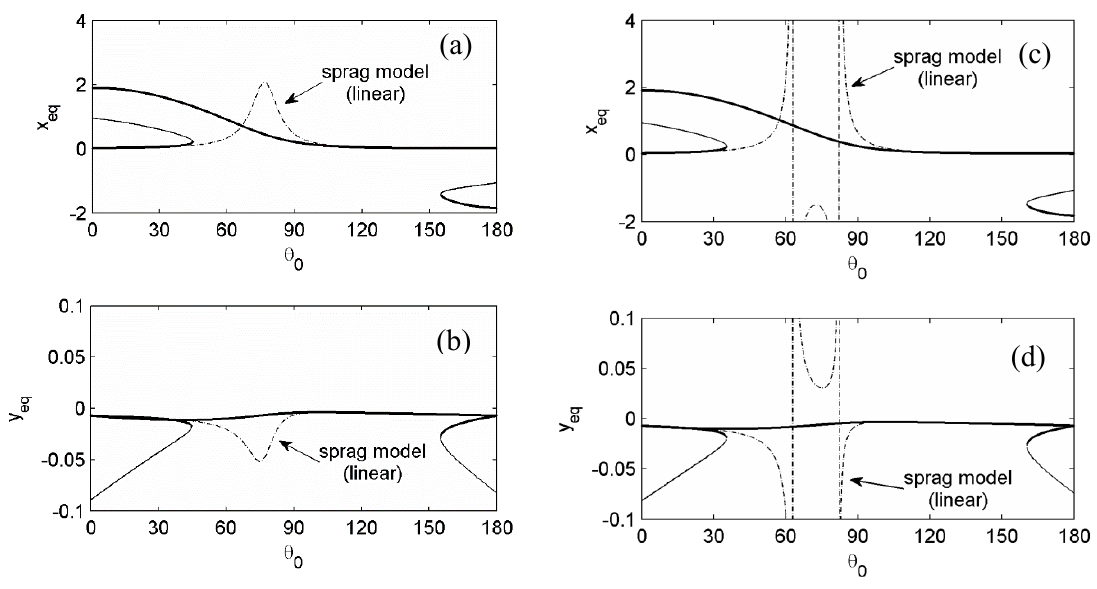
Figure 5. Equilibrium curves with respect to θ o for n (cid:44) 0 ( a ) x eq at µ o = 0.5, ( b ) y eq at µ o = 0.5, and ( c ) x eq at µ o = 0.7, ( d ) y eq at µ o =